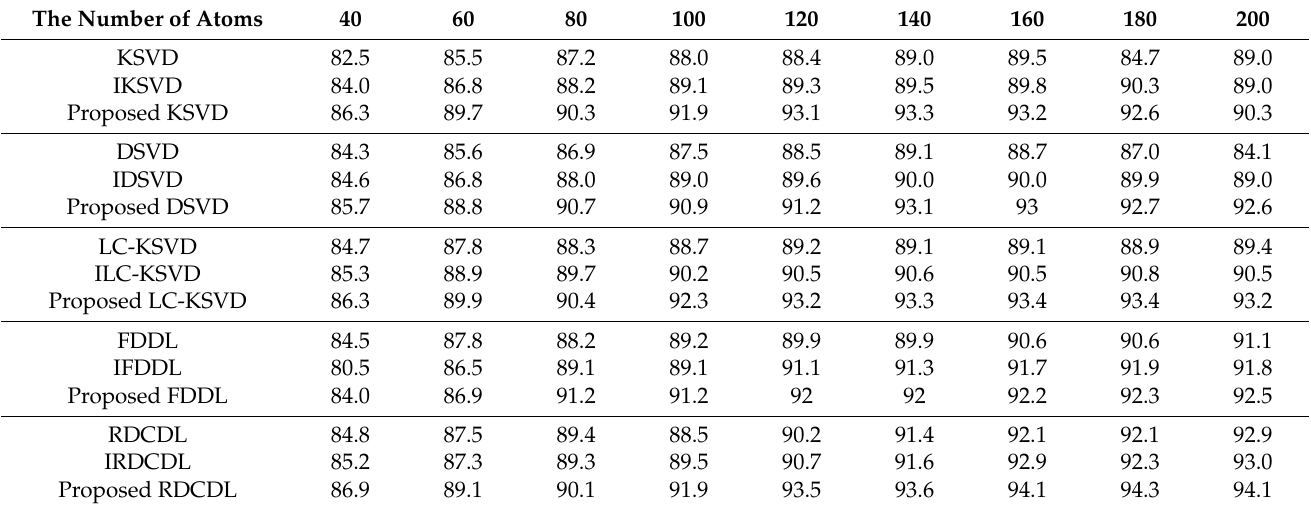
Table 4. Average accuracy (%) on the COIL-20